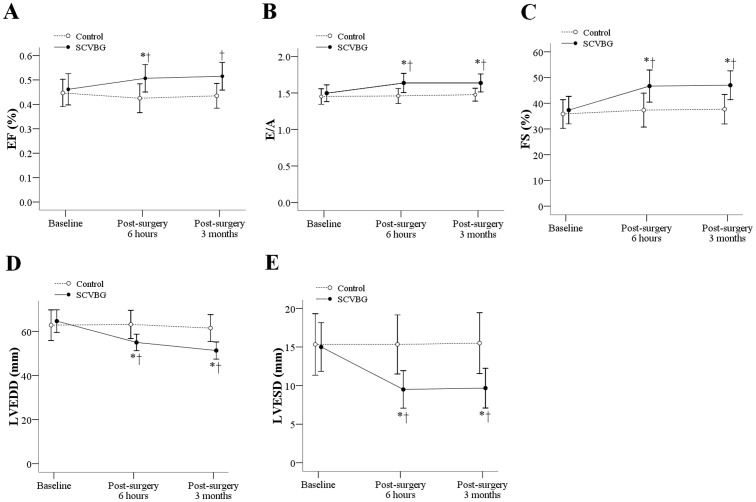
Changes in echocardiographic parameters from baseline to postoperative 6 months.(A) EF, (B) E/A ratio, (C) LVEDD, (D) LVESD, (E) FS. Data are presented as mean and standard deviation. In SCVBG group, EF was significantly higher than at baseline (p = 0.0038) than at postoperative 6 hours; E/A ratios were significantly higher than baseline (p = 0.0067 and 0.009) at postoperative 6 hours and 3 months. EF, E/A, and FS in SCVBG group were significantly higher than in control group at postoperative 6 hours and 3 months (EF: p = 0.0341 and p = 0.0271; E/A ratio: p = 0.0269 and p = 0.0268; FS: p = 0.030 and p = 0.017). LVEDD and LVESD in SCVBG group were significantly lower than in control group at postoperative 6 hours and 3 months (LVEDD: p = 0.027 and 0.006; LVESD: p = 0.016 and p = 0.019). EF, ejection fraction; E/A, E/A ratio, E: the peak early diastolic transmitral flow velocity; A: atrial peak transmitral flow velocity; SCVBG, selective coronary vein bypass graft. *indicates a significant difference compared to baseline within group. †indicates a significant difference between control and SCVBG groups at the specific time point(s).